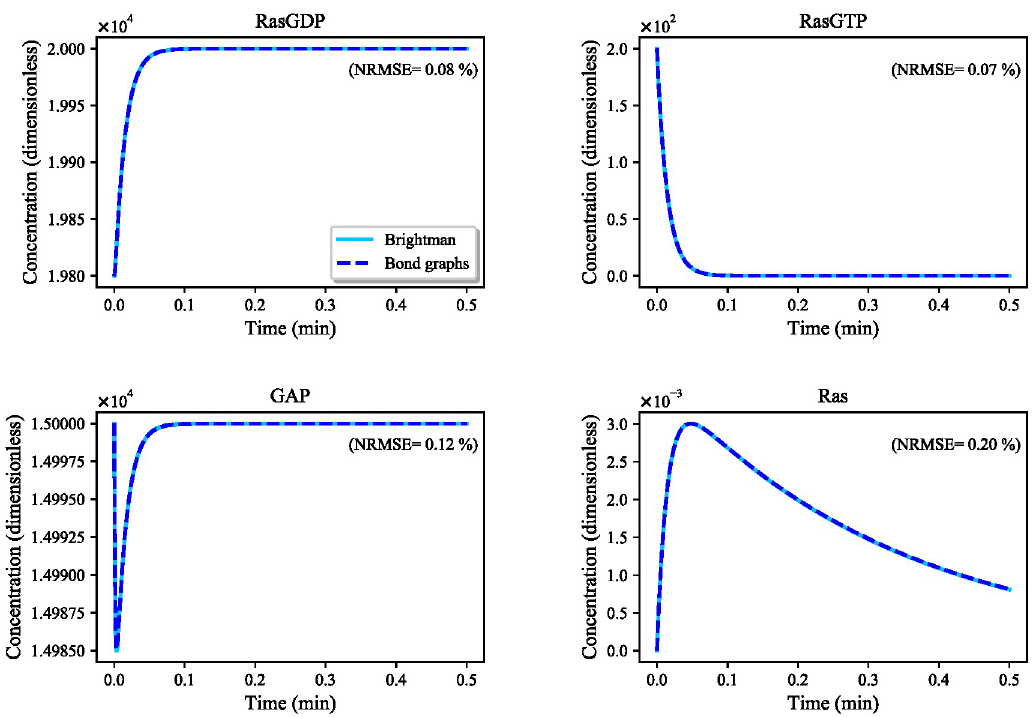
Fig 12. Comparison between the reduced Brightman & Fell Ras activation model and its bond graph approximation. The simulations are given for four species. NRMSE is calculated for each comparison in percentage. The initial amounts in this simulation were 0 except for: RasGDP = 19800, RasGTP = 200, GAP = 15000.